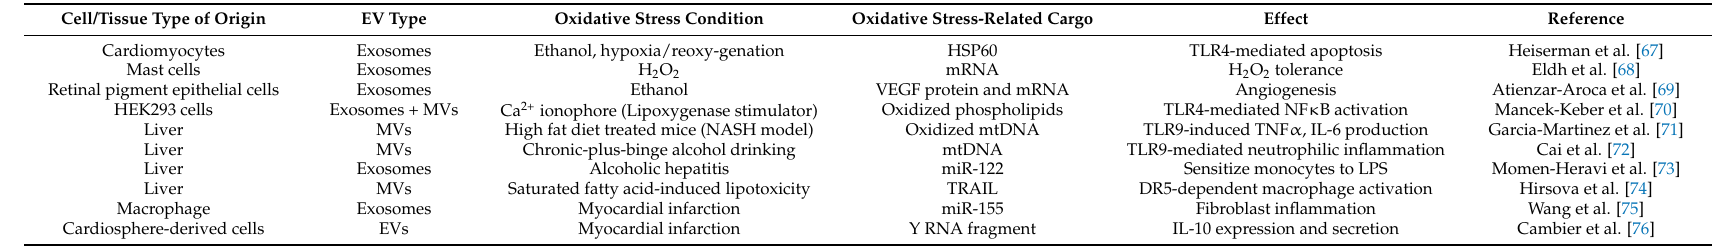
Table 1. Role of oxidative stress-related EVs on cell viability and tissue